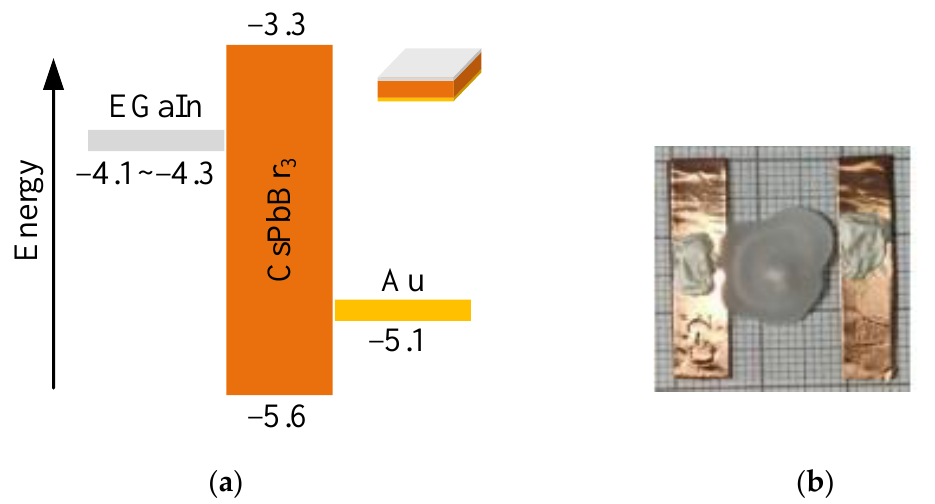
Figure 1. Architectural properties for CsPbBr 3 detectors ( a ) Energy band diagrams for CsPbBr 3 detector using asymmetrical electrode materials. ( b ) Top-view photograph of the CsPbBr 3 detectors. As indicated in the insert, the dimension of the crystal is 3 × 3 mm 2 , where the thickness is 1 mm.